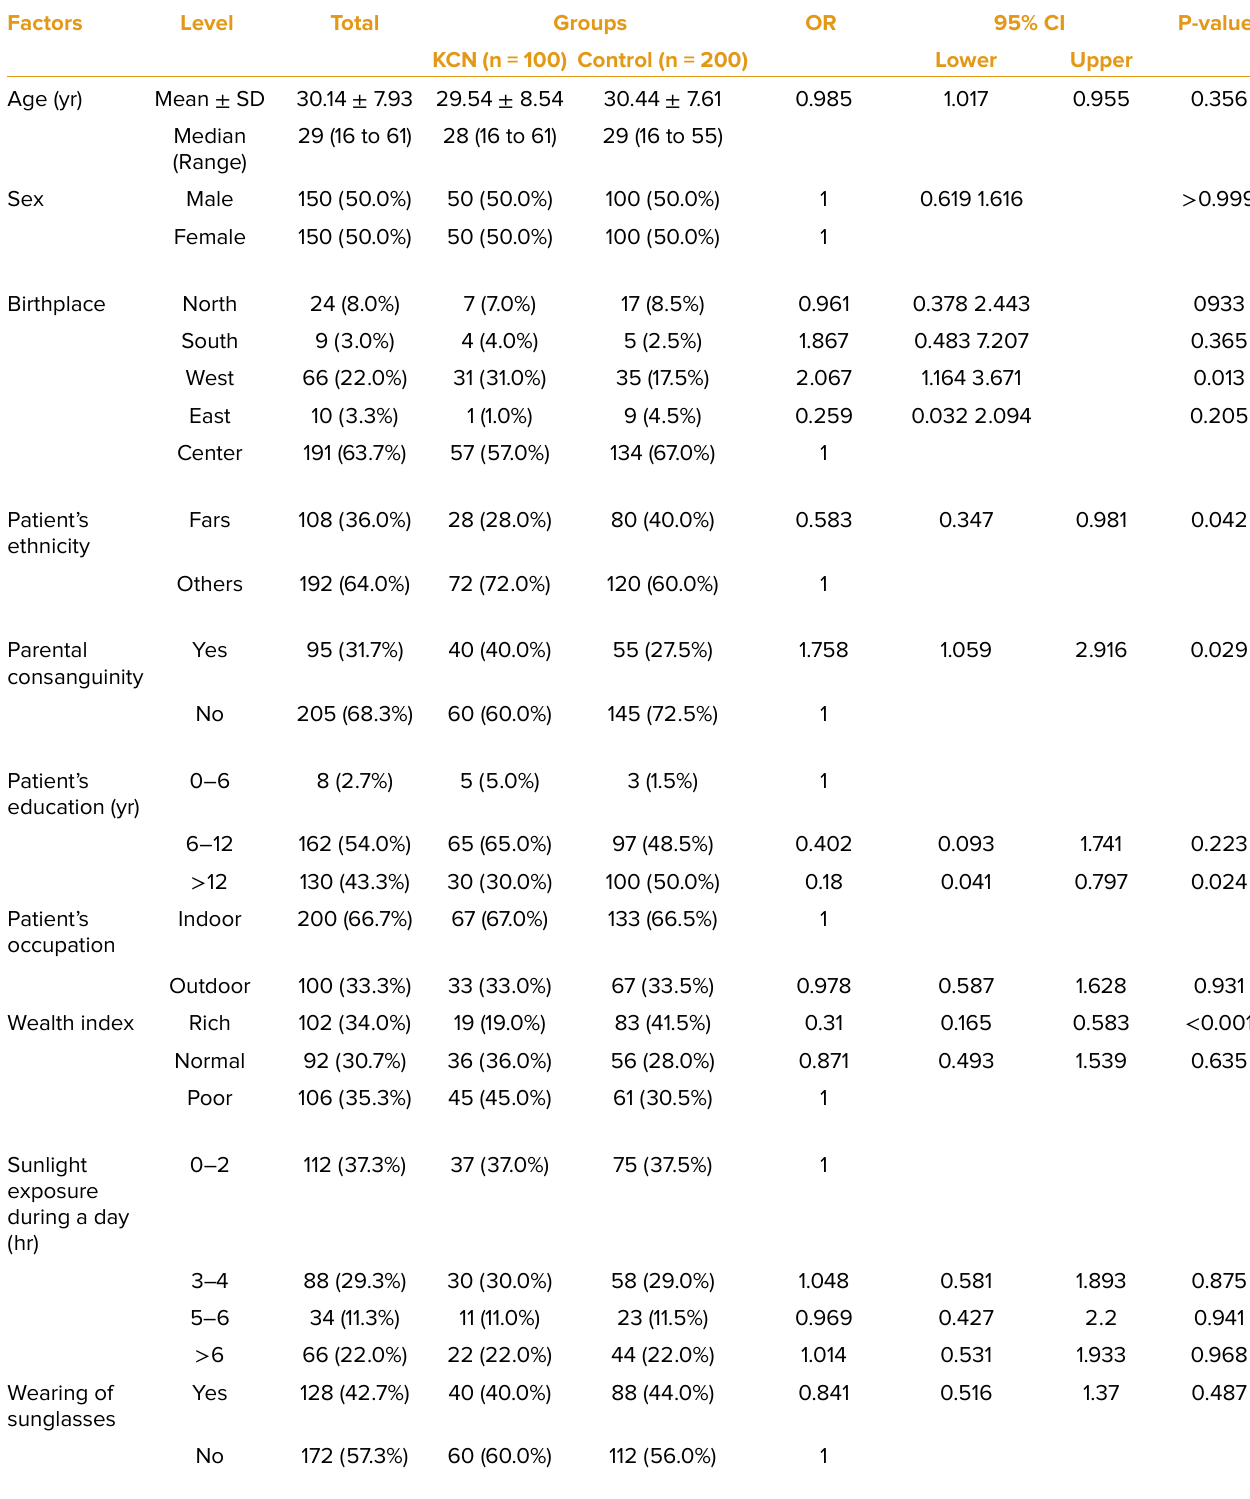
Table 1. Comparison of demographic characteristics between case and control